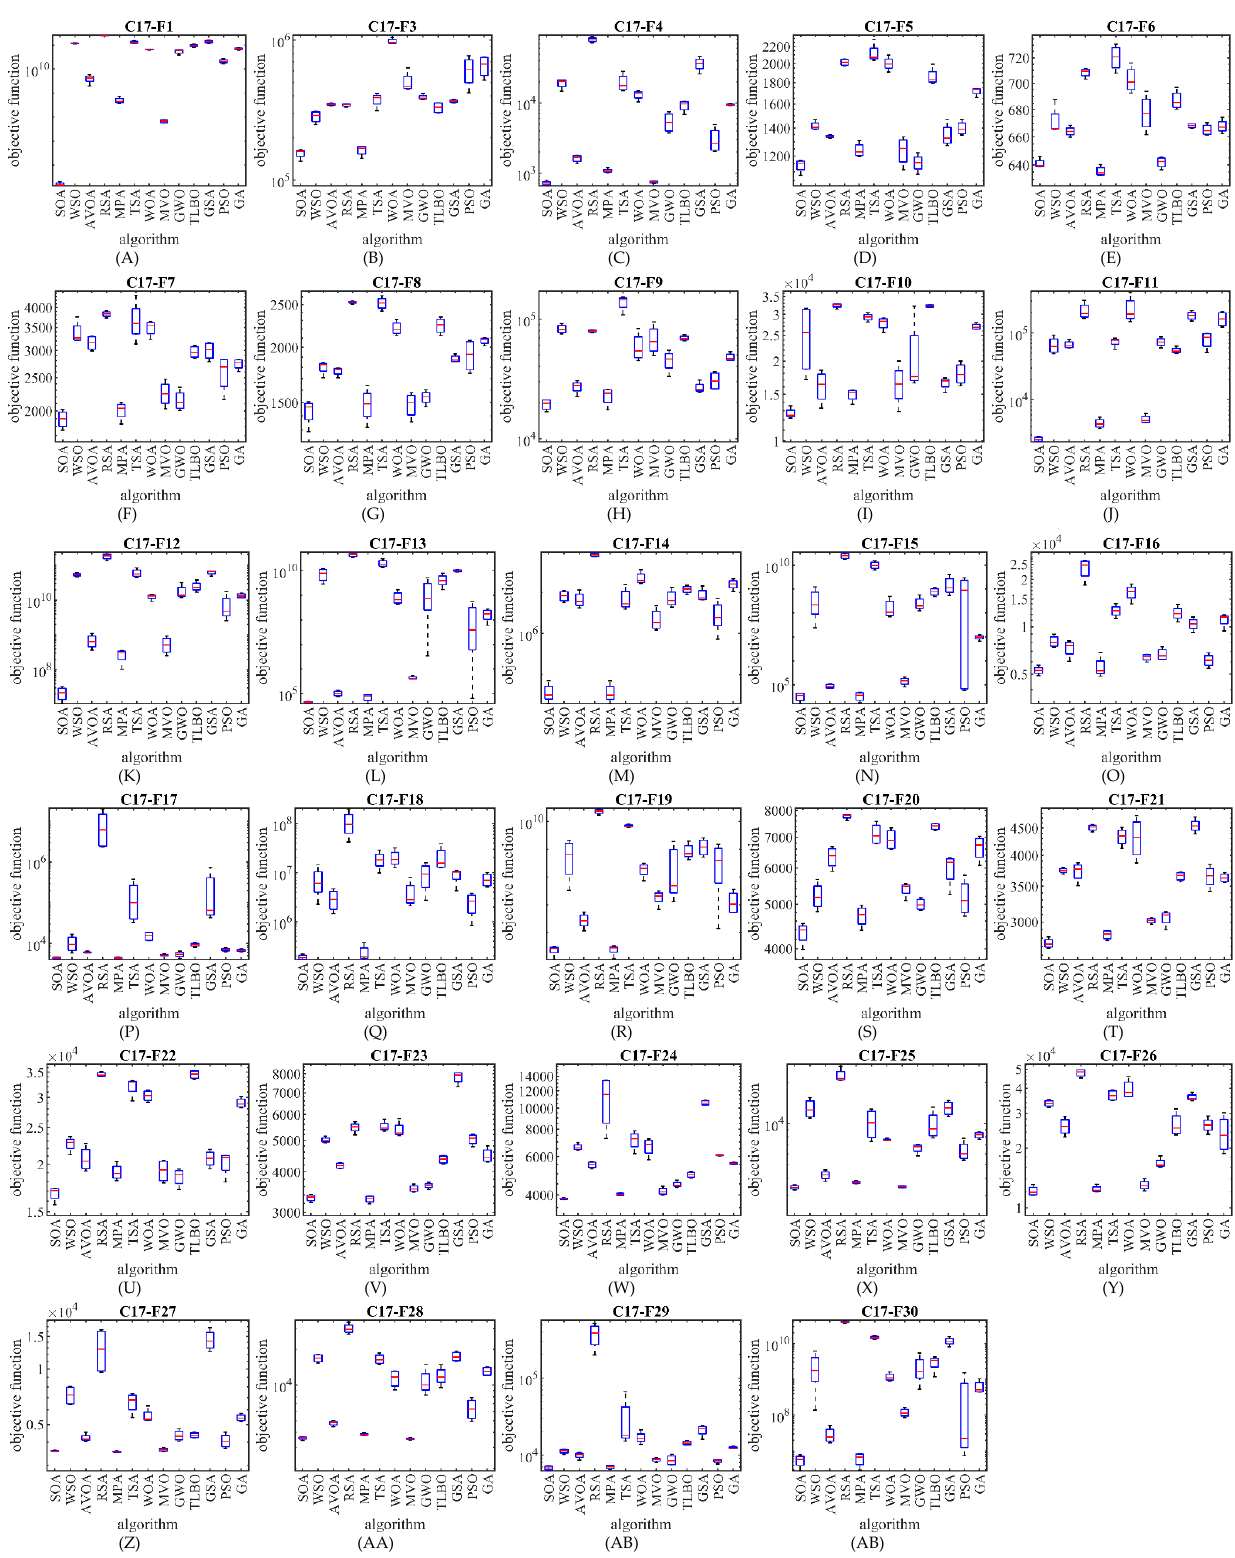
Figure 4. Boxplot diagram of SOA and competitor algorithms performances on the CEC 2017 test suite (for the dimension 𝑑 = 50 ).